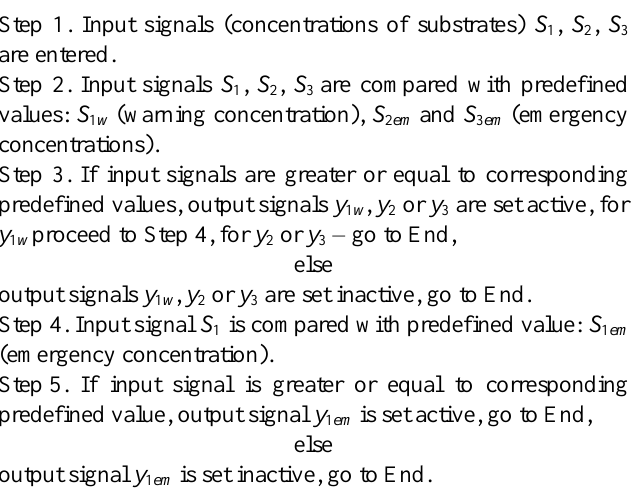
Fig. 9. Algorithm of biosensor control system.